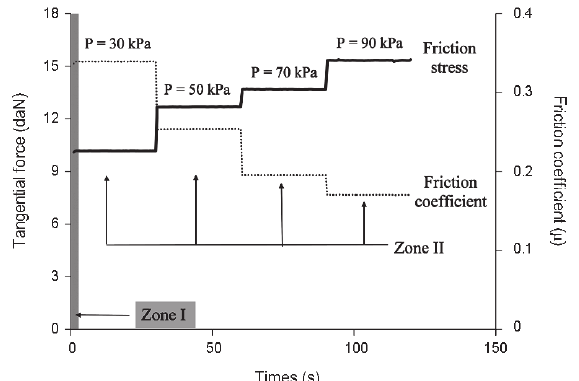
Fig. 6. Soap molecule (carboxylate ion) (a) and diagram of micelles (b)